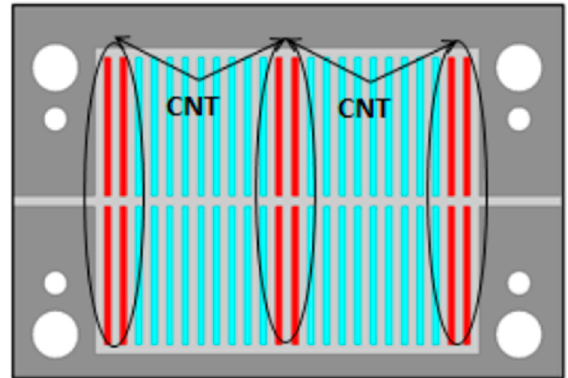
Figure 7. Location of the sensitive layer: 1st and 2nd mode.